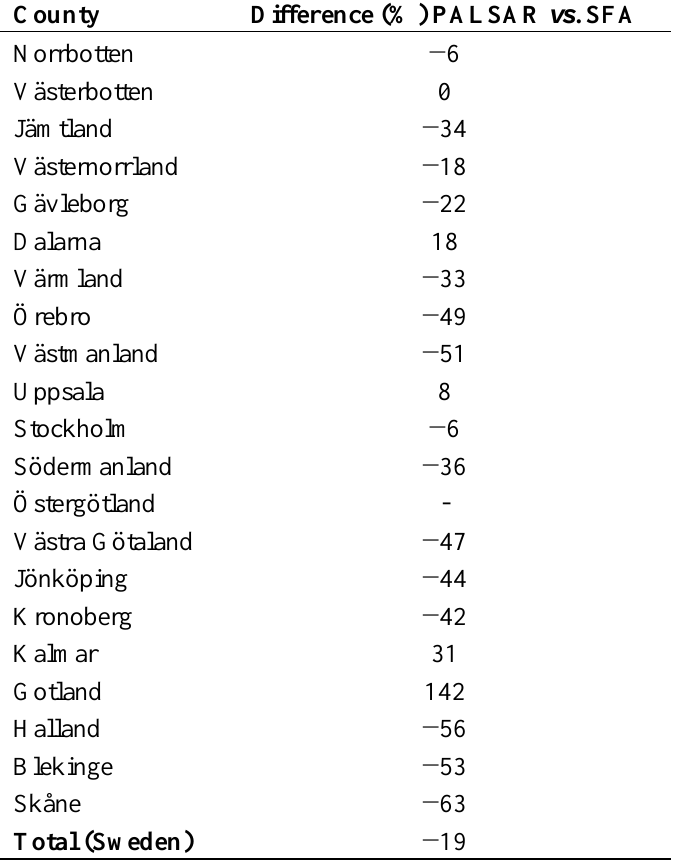
Table 6. Difference in percent between PALSAR-based and SFA estimates of clear-felled area at county level for the average statistics in Table